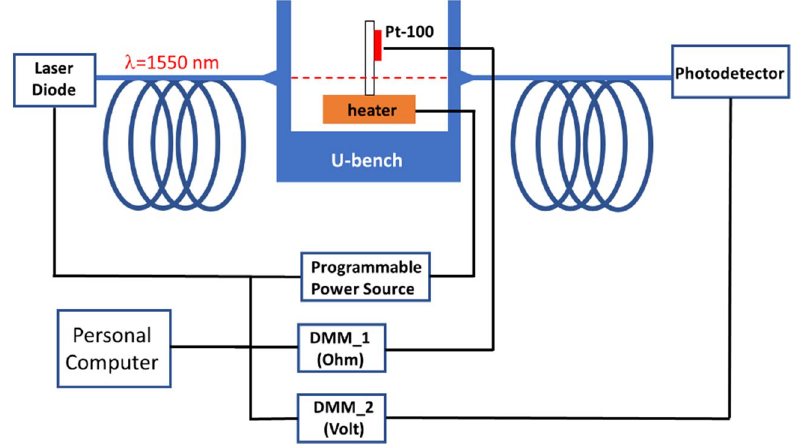
Figure 1. Experimental setup exploited for TOC characterization versus